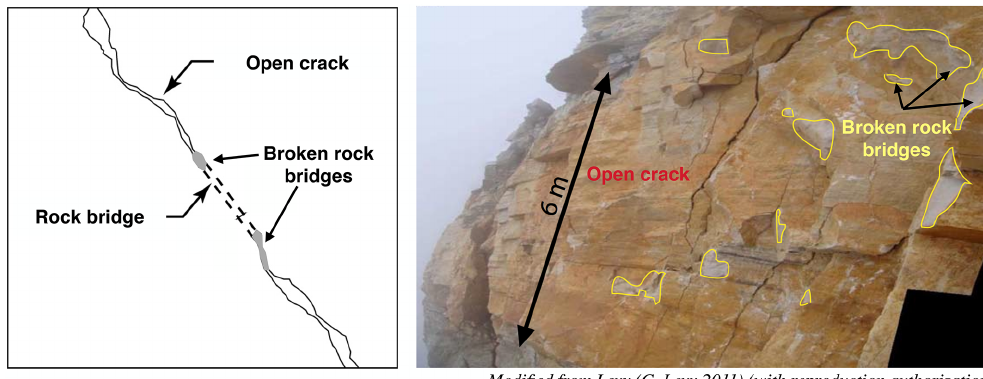
Figure 1. Left: definition of rock bridges; right: open-crack and failed-rock-bridge areas. Modified from Levy (2011) (with reproduction authorization).